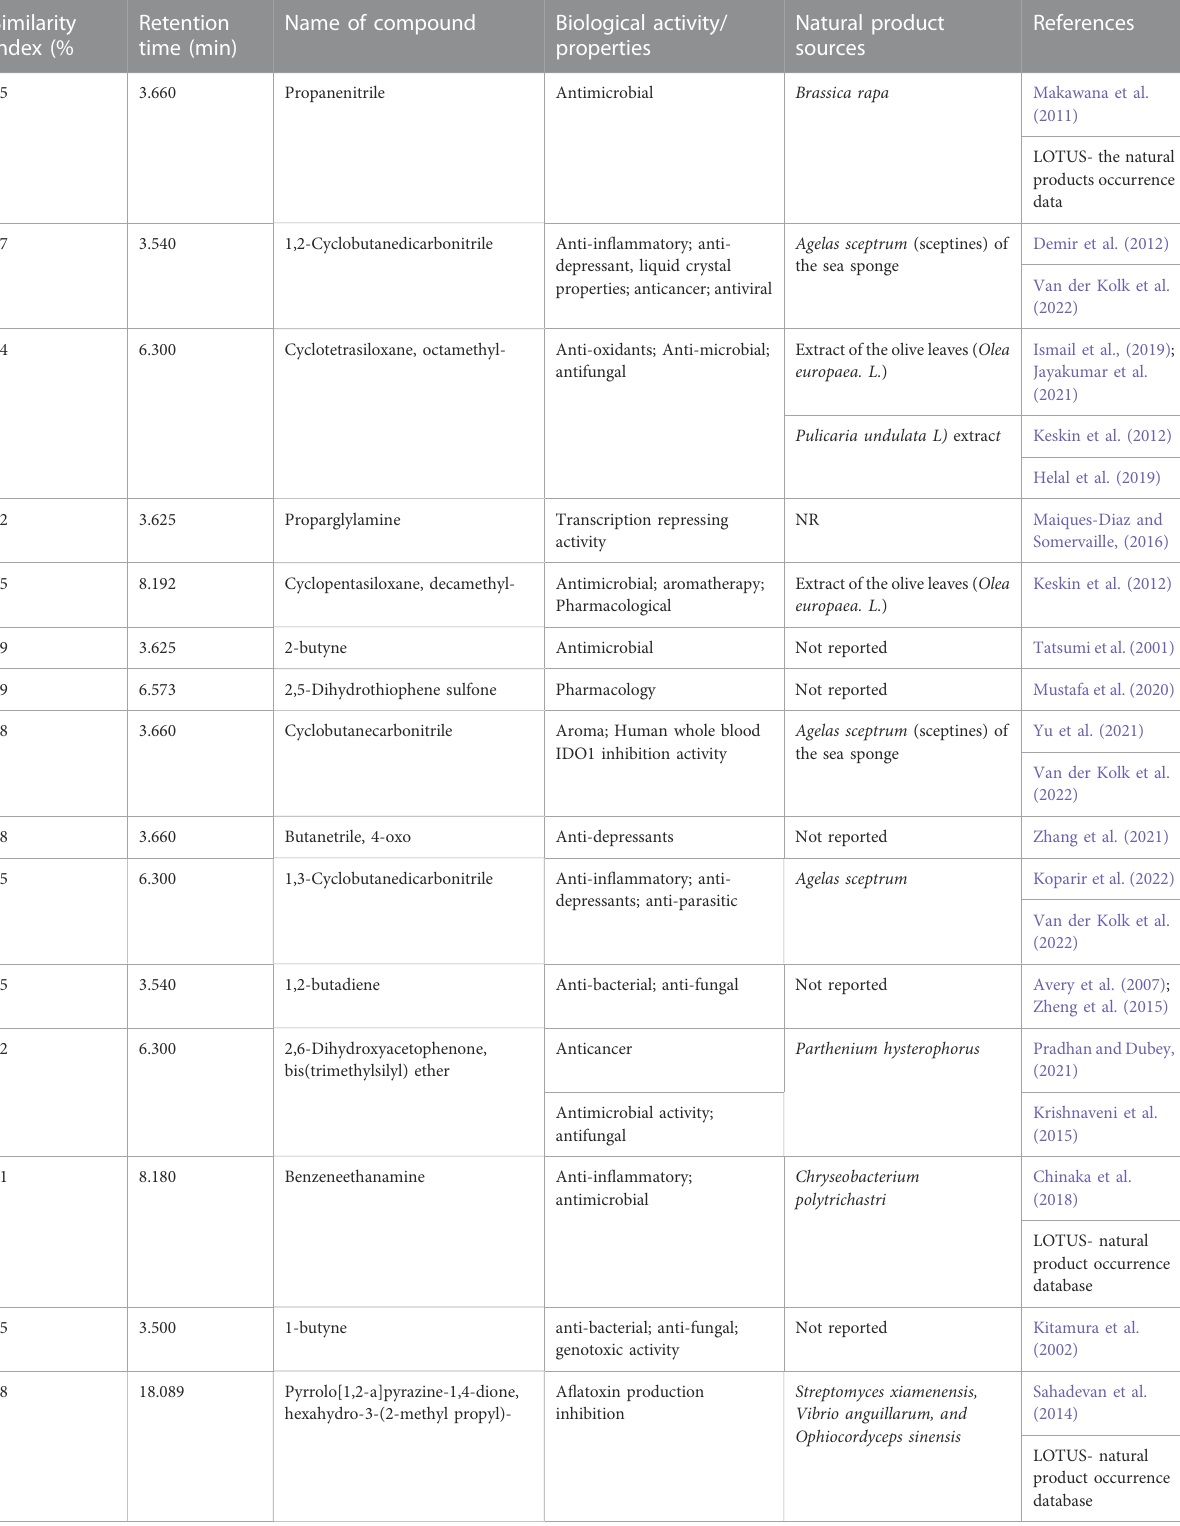
TABLE 4 GC-MS analysis of secondary metabolites of endophytic fungi PO4PR2 ( A. alternata isolated from Hypoxis plant crude methanol extracts) separated using HLB, MCX and MAX cartridges. Similarity index